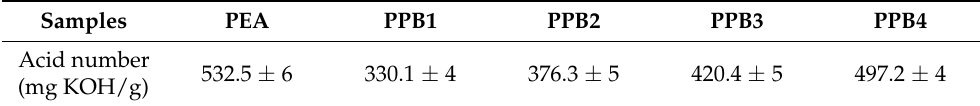
Scheme 2. Synthesis route of flexible phosphate esters (PPBs) flame retardants. Table 1. The acid number values of PEA and PPBs flame retardants. Samples